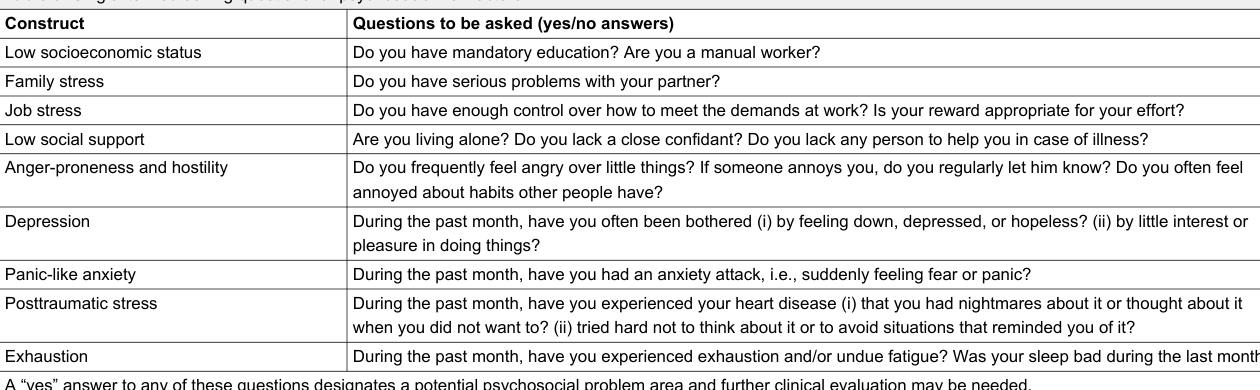
Table 3: Single item screening questions for psychosocial risk factors. Construct Questions to be asked (yes/no